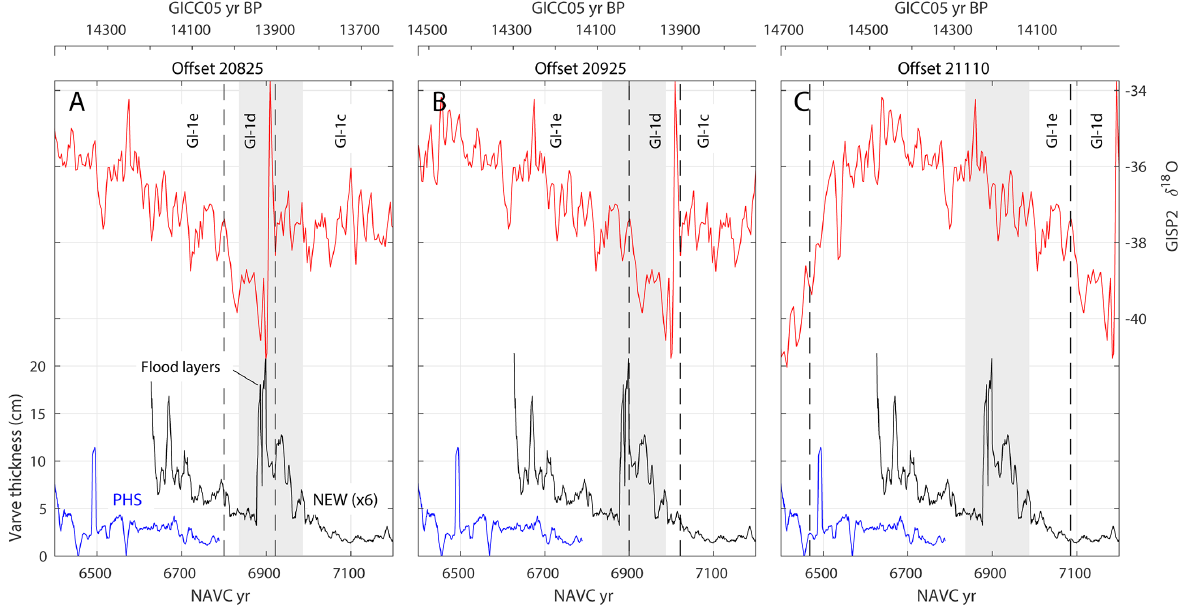
Figure 24. Correlation between NAVC and GISP2 climate proxy records near 14000 GICC05yrBP. This duplicates Fig. 14 of Thompson et al. (2017), except that the x axis is reversed for consistency with the rest of the figures in this paper. Records at the bottom are 9-year running averages of varve thickness records from Newbury (NEWB) and Perry Hill Basin (PHS; see Ridge et al., 2012). The GISP2 δ 18 O record (Stuiver et al., 1995; Stuiver and Grootes, 2000) is a three-sample running average on the GICC05 chronology. The gray band shows the minimum duration of the Littleton–Bethlehem Readvance inferred from varves directly underlying and overlying the readvance till (see Thompson et al., 2017). Panel (a) uses the offset proposed as the best event correlation by Ridge et al. (2012) and Thompson et al. (2017), which is the same as the offset derived from fitting to INTCAL13 by Thompson et al. (2017). Panel (b) uses the offset that provides the best match between the 10 Be flux at Newbury and the ice core stack (Fig. 22). Panel (c) uses the offset that provides the best match between the 10 Be flux at KF–GL and the ice core stack (Fig. 18). Note that the anomalously thick varves near NAVC 6900 (highlighted in a ) are related to a lake outburst flood and therefore have no climate significance (see Ridge et al., 2012). The Greenland climate event boundaries are from Rasmussen et al.